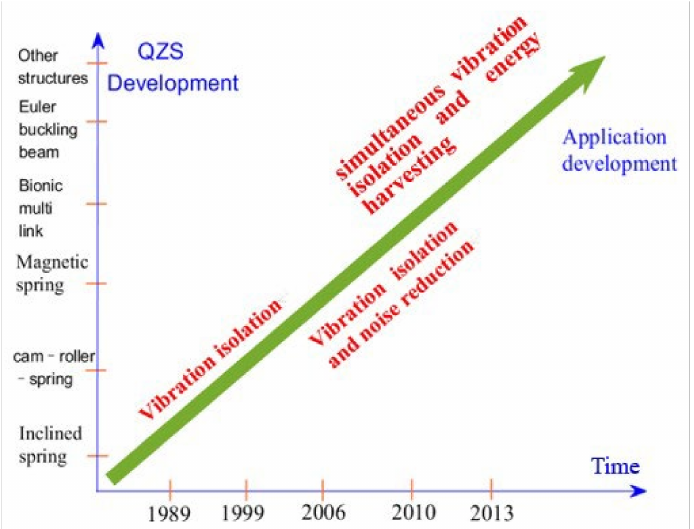
Figure 4. Development of QZS-based vibration